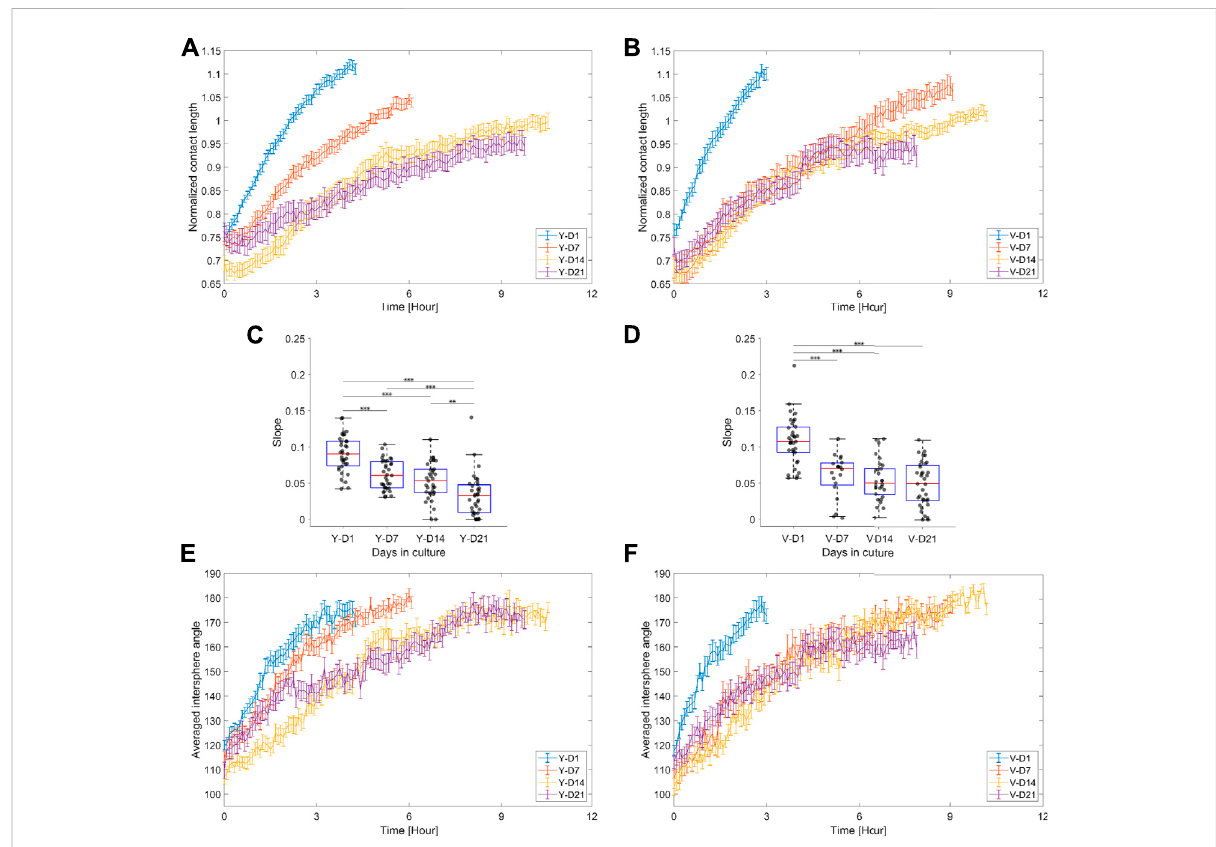
FIGURE 7 Normalized contact length and averaged intersphere angle. (A,B) Average response ±SEM of the normalized contact length for the different maturation stages, respectively, for the Y and V pools. (C,D) Box plots of the integration rate, i.e., the slope extracted from the linear model fi t on the normalized contact length (data up to 5 h were considered), for the different maturation stages, respectively, for the Y and V pools. Data were compared with one-way ANOVA and the Tukey – Kramer post hoc test. Signi fi cance was visualized with *: p < 0.05; **: p < 0.01; ***: p < 0.001. (E,F) Average response ±SEM of the averaged intersphere angle for the different levels of maturation, respectively, for the Y and V pools. 20 – 35 doublet samples were analyzed per